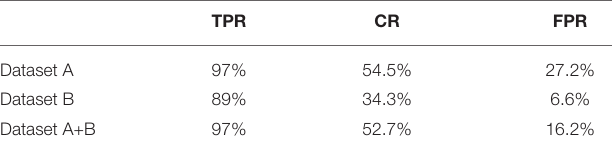
TABLE 6 | Performance comparison with different thresholds with a window size of